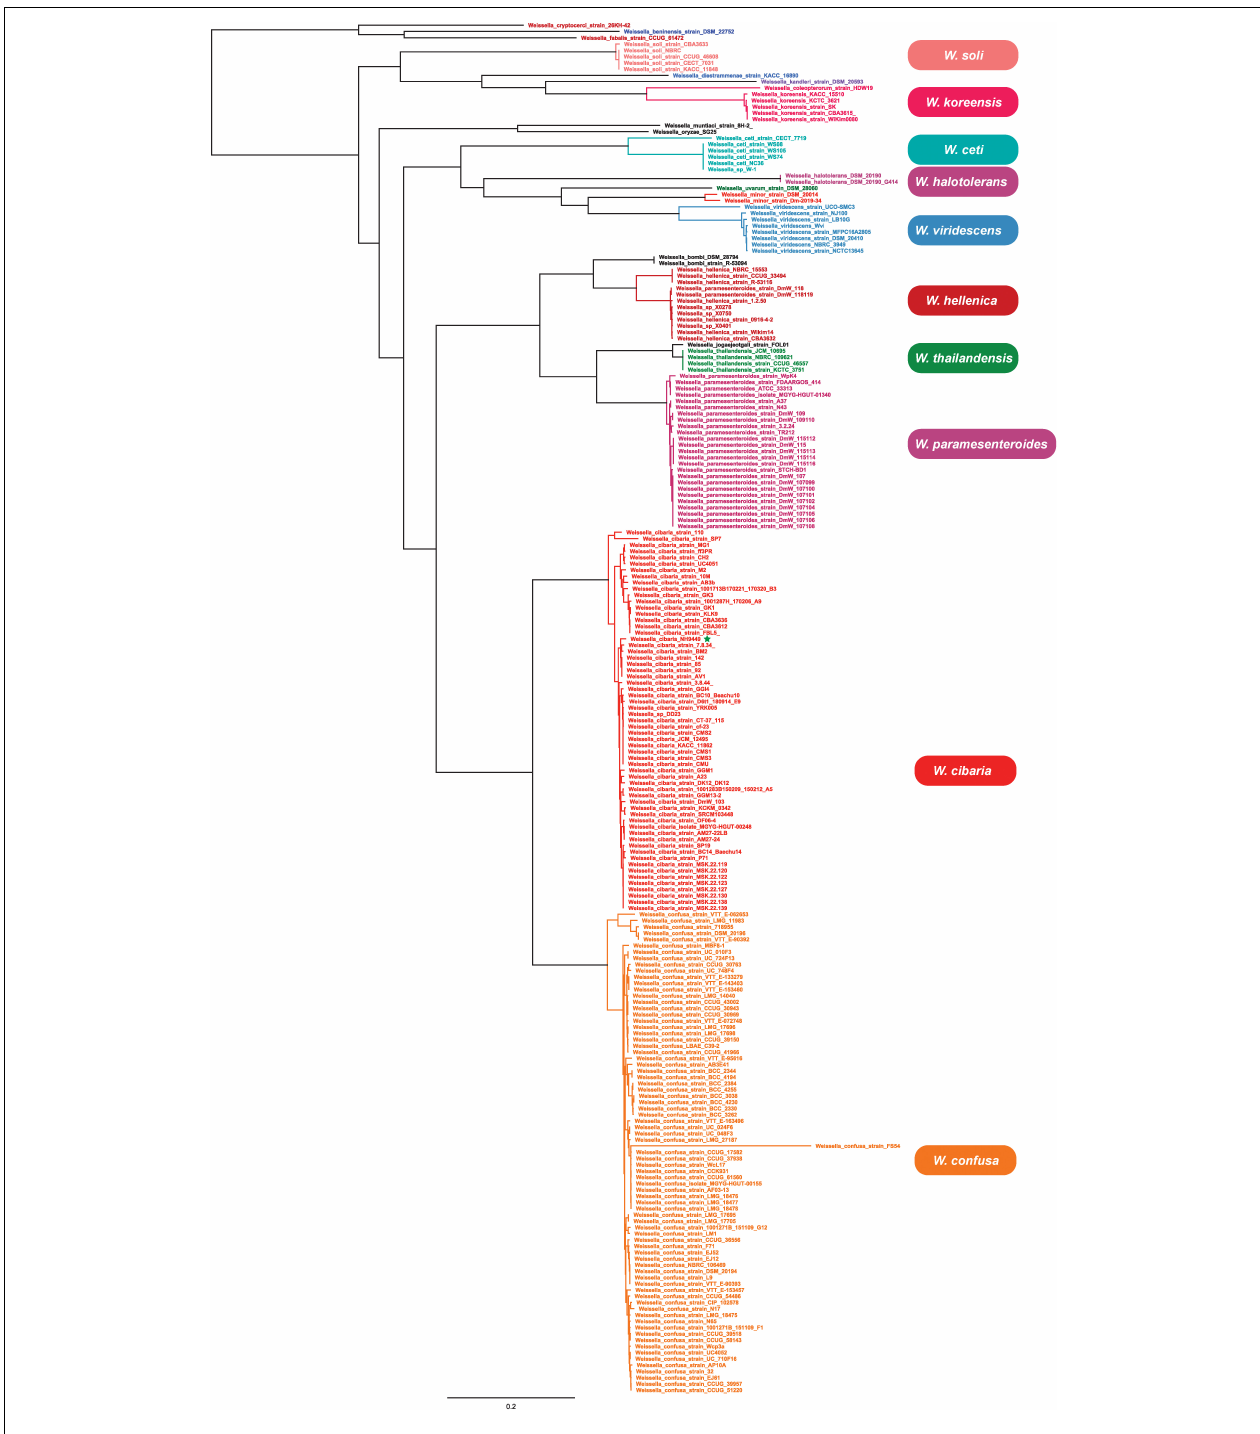
FIGURE 7 | The phylogenetic tree is based on the core genes of 219 Weissella